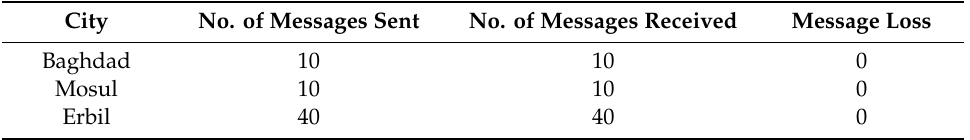
Figure 13. Messages sent to the smartphone at the MECC with ( a ) received message details and ( b ) location on the Google map. Table 4. Results of test message delivery in different cities of Iraq.